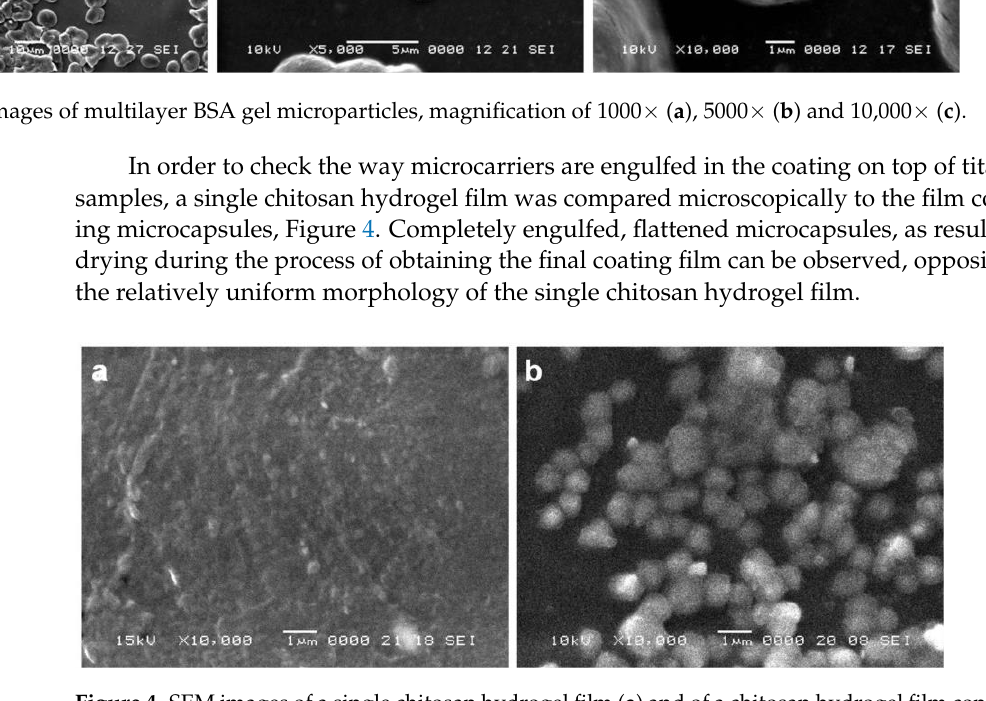
Figure 4. SEM images of a single chitosan hydrogel film ( a ) and of a chitosan hydrogel film containing the loaded microcarriers ( b ).